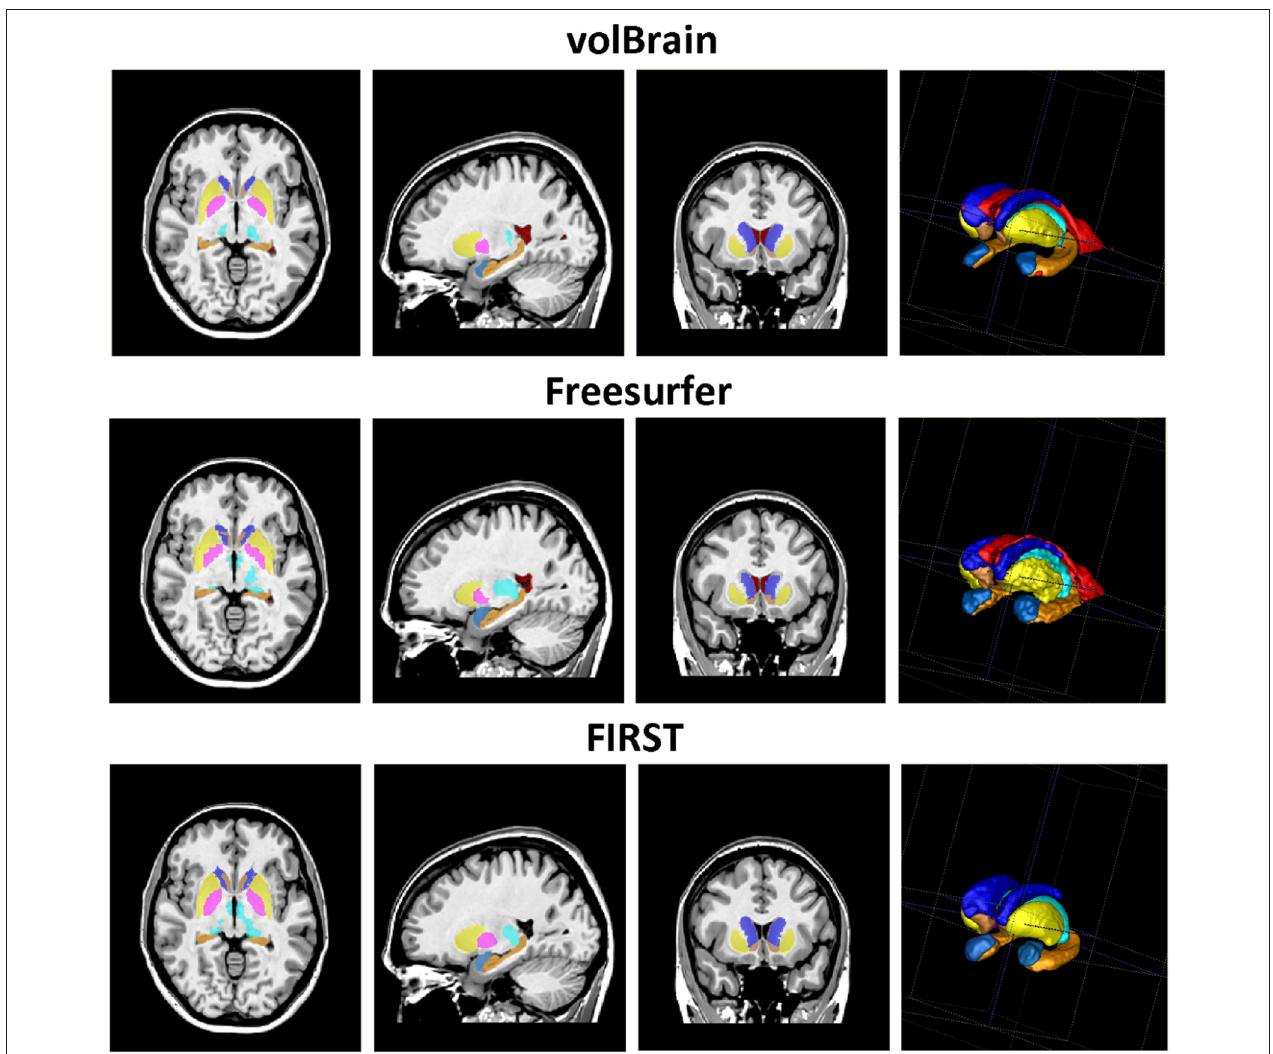
FIGURE 5 | Visual example of the segmentation results (Axial, sagittal, and coronal views and 3D representation of segmented subcortical structures). First row: volBrain results. Second row, Freesurfer results; Third row, FIRST results. Note that FIRST output does not include lateral